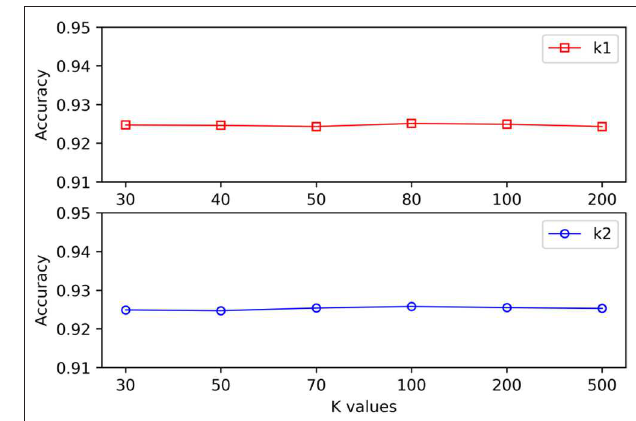
FIGURE 2 | Influence of feature combination on model prediction accuracy.